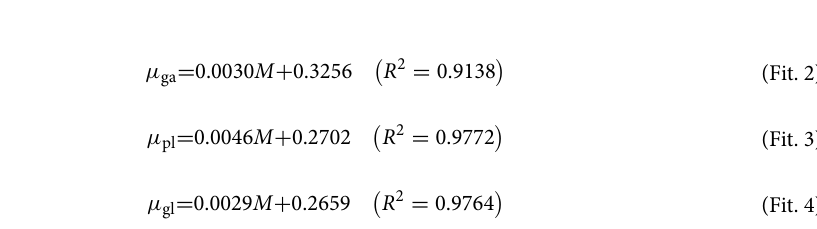
Figure 3. Relationship between moisture content and hardness of Cassia tora L. seeds measured along different